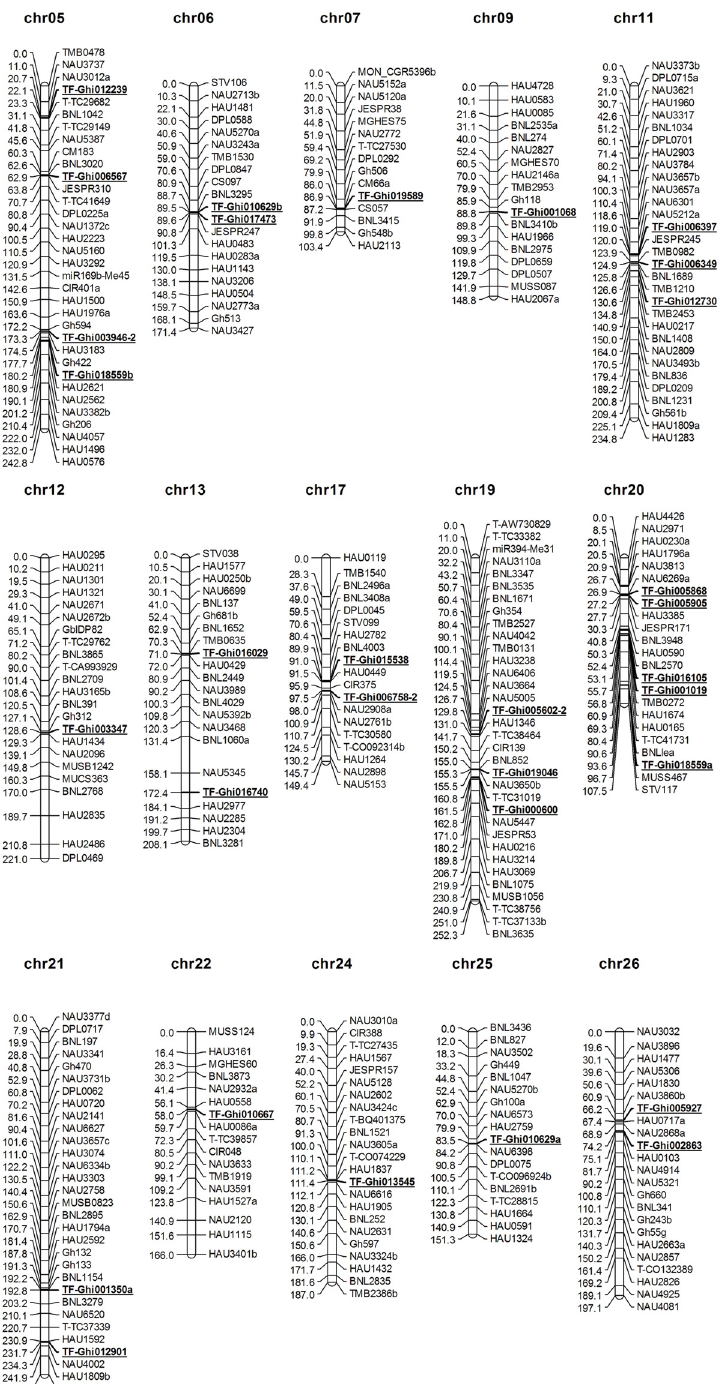
Fig 2. Locations of polymorphic TF loci on the BC 1 genetic linkage map. TF markers are underlined and bolded. The loci on each chromosome with an average of 10 cM of the original map were selected shown. The top and bottom markers and markers that were closely linked to the TF markers were retained for simplicity.